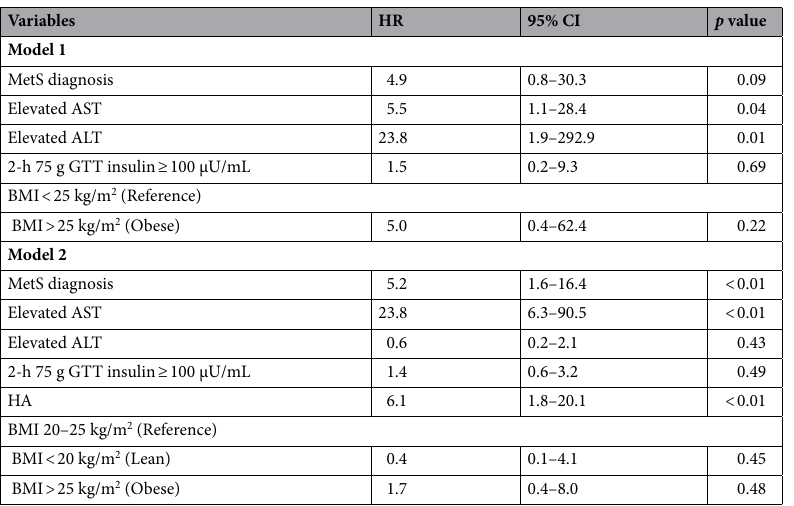
Table 5. Multivariate analysis of variables associated with NAFLD in adolescents and adults. (a) Model 1: Adolescent group. (b) Model 2: Adult group. The categorical variables were MetS component (reference: none), number of MetS components (reference: number 0), Elevated AST (reference: normal AST level at PCOS diagnosis), Elevated ALT (reference: normal ALT level at PCOS diagnosis), 2-h 75 g GTT